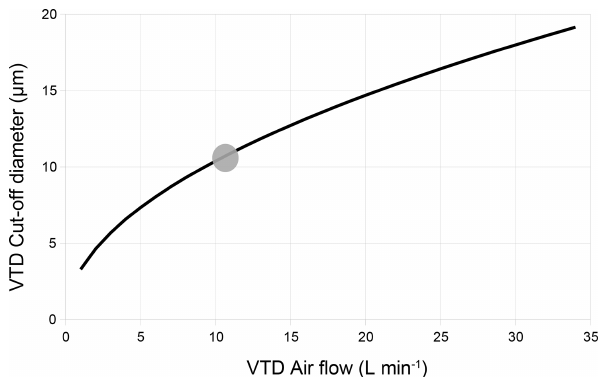
Figure 4. Calculated particle cut-off diameter (µm) for the VTD as a function of airflow. Calculations are performed using Stokes’ equations for a vertical cylinder with a diameter of 125mm. The grey dot shows actual operating conditions, with measured airflows varying between 10 and 12Lmin − 1 , leading to a cut-off diameter between 10 and